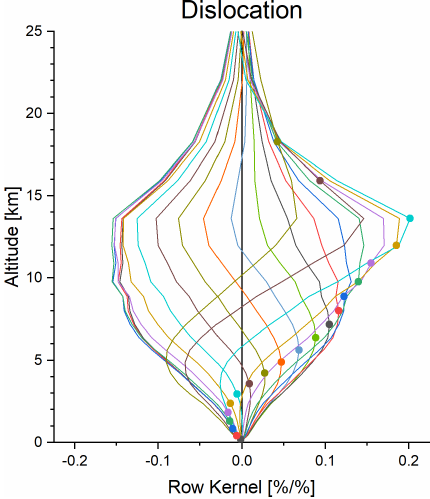
Figure E4. Example of dislocation kernel A l cording to Eq. (E3) – for the same late summer observation as used in the context of Figs. 1 to